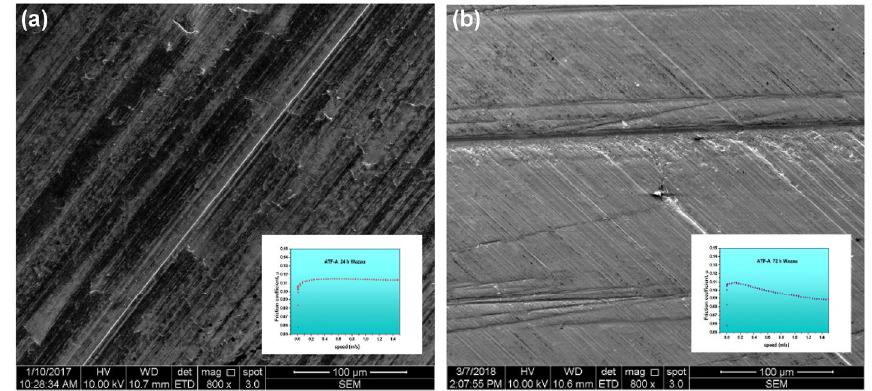
Fig. 3 SEM images of post-test steel disc surfaces after (a) 24 h and (b) 72 h Wazau durability tests for ATF-A.